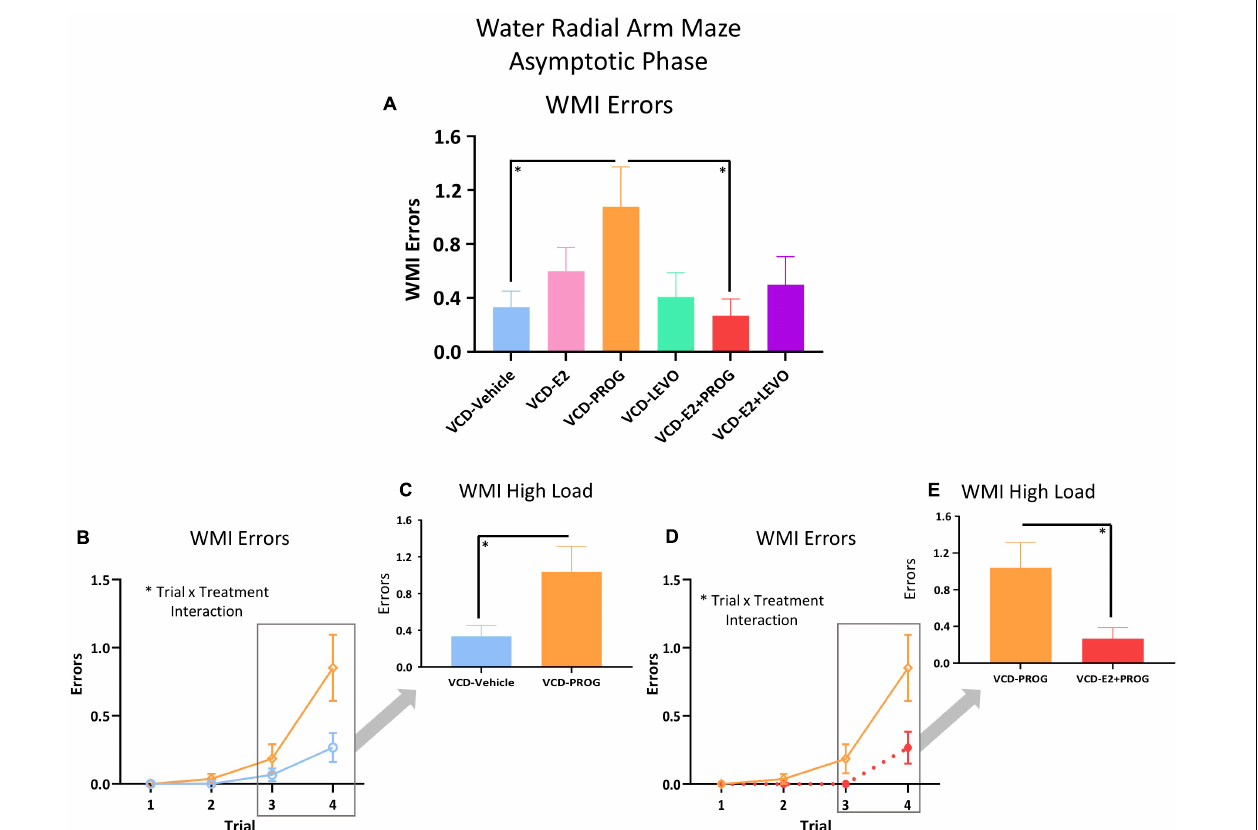
FIGURE 5 | WMI Errors During the Asymptotic Phase. (A) Across all trials, a main effect of Treatment was present between the VCD-PROG group and the VCD-Vehicle group ( p < 0.05) as well as compared to the VCD-E2 + PROG group ( p < 0.05). (B) VCD-PROG vs. VCD-Vehicle comparison: A Trial × Treatment interaction was present for this comparison ( p < 0.05) (C) When High Load trials (Trials 3 + 4) were assessed, VCD-PROG rats made more WMI errors than VCD-Vehicle rats ( p < 0.05). (D) VCD-PROG vs. VCD-E2 + PROG comparison: A Trial × Treatment interaction was present for this comparison ( p < 0.05). (E) When High Load trials (Trials 3 + 4) were assessed, VCD-PROG rats made more WMC errors than VCD-E2 + PROG rats ( p < 0.05). Significance: ∗ = p <